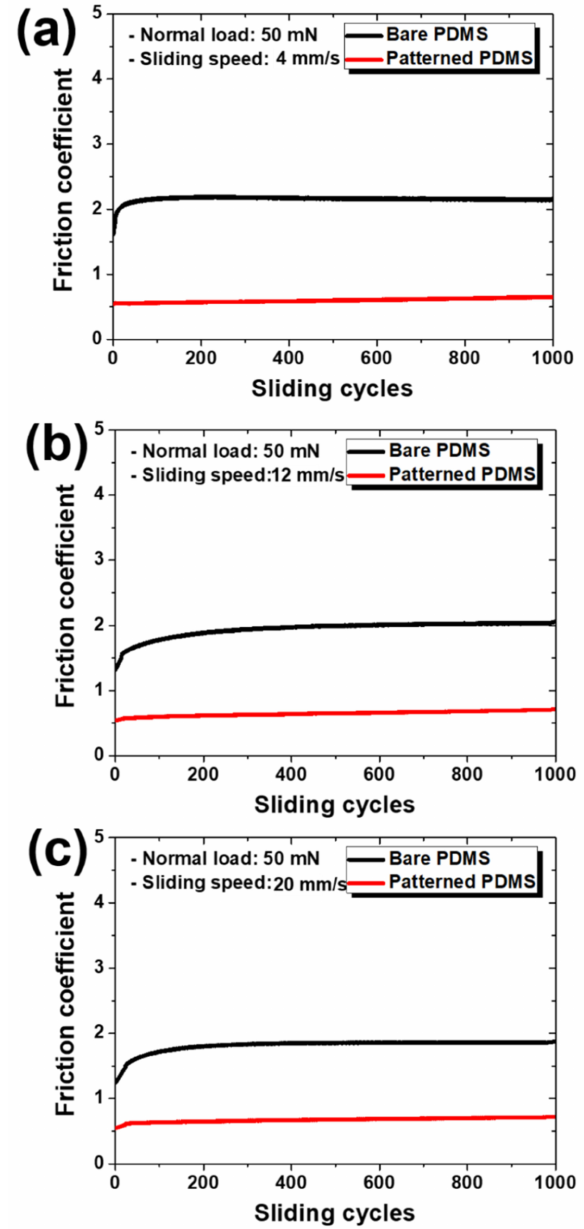
Figure 7. Variations in friction coefficients according to sliding cycles at sliding speeds of ( a ) 4 mm/s, ( b ) 12 mm/s, and ( c ) 20 mm/s under a normal load of 50 mN for bare PDMS and micro/nanopatt- erned